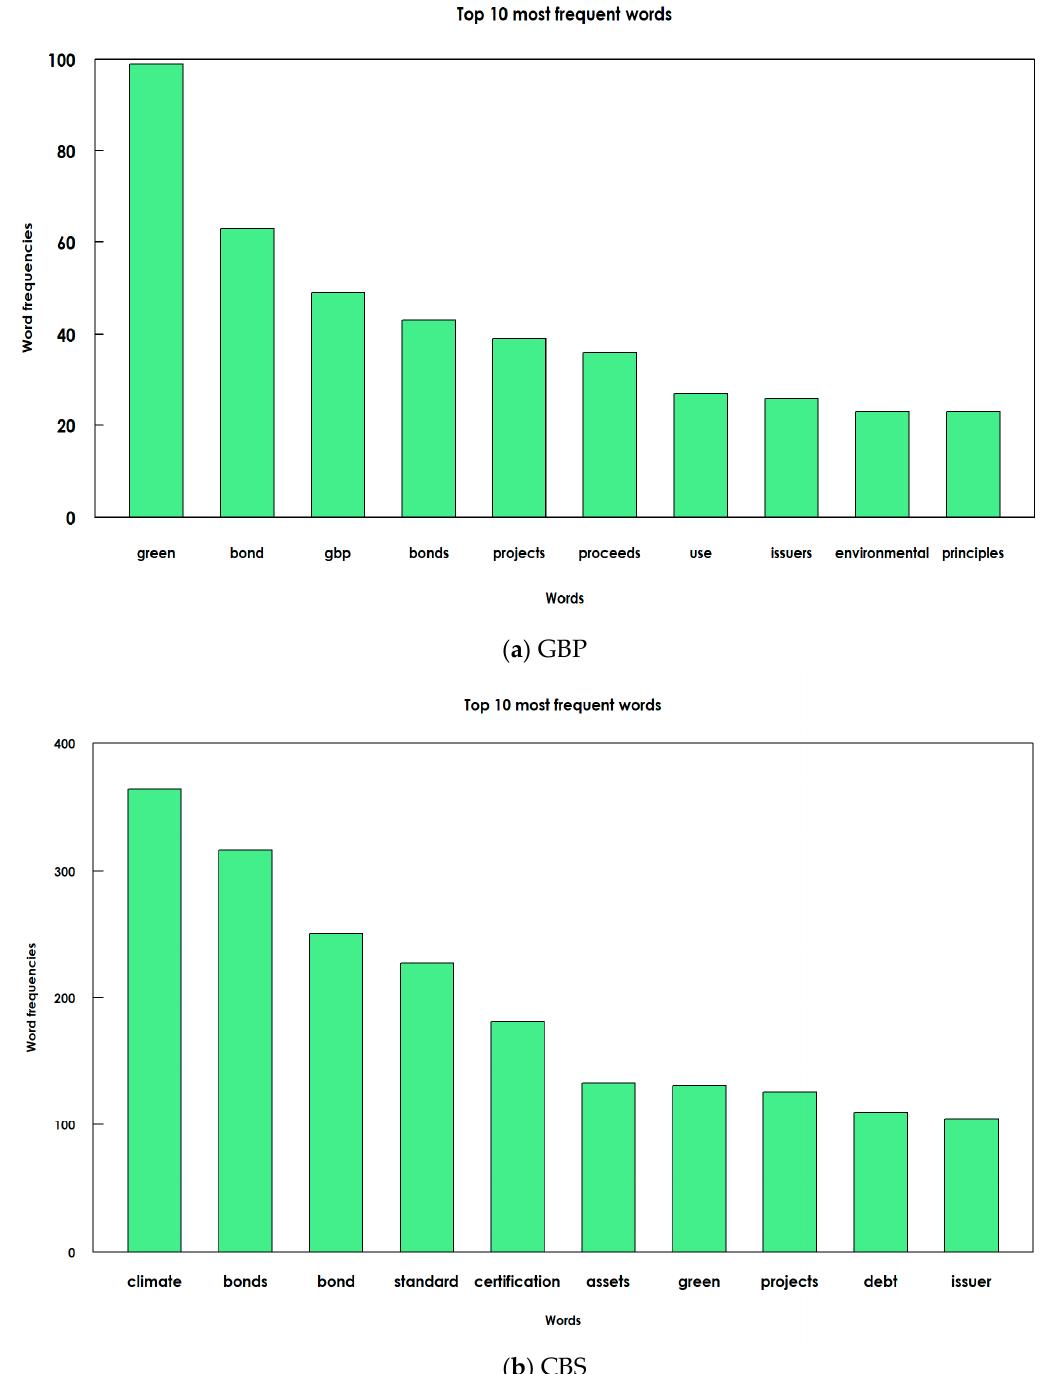
Figure 2. Most frequent words in the international GB guidelines .